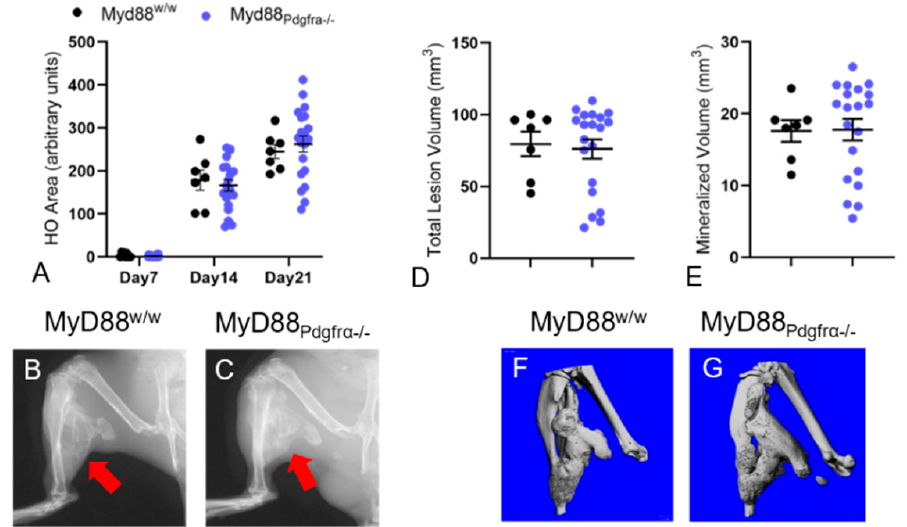
Figure 2. Conditional deletion of MyD88 in PDGFR α + cells in Acvr1 R206H_FlEx/wt mice did not affect muscle injury-induced EHO area and volume. ( A ) Semiquantification of intramuscular HO area in radiographs and ( D , E ) µ CT-based quantification of HO volume demonstrated unaffected HO area ( A ), total lesion volume ( D ), and mineralized volume ( E ) in Acvr1 R206H_FlEx ;MyD88 Pdgfr α − / − vs. Acvr1 R206H_FlEx ;MyD88 w/w mice. Representative radiographs ( B , C ) and µ CT reconstructions ( F , G ) of representative samples at 21 dpi illustrating extensive EHO (red arrows) in both genotypes. Statistical significance was tested using Kruskal–Wallis test or a two-tailed unpaired Student’s t -test. No significant differences were found.